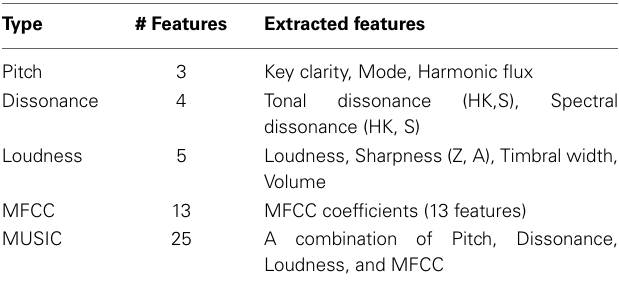
Table 2 | A summary of music feature